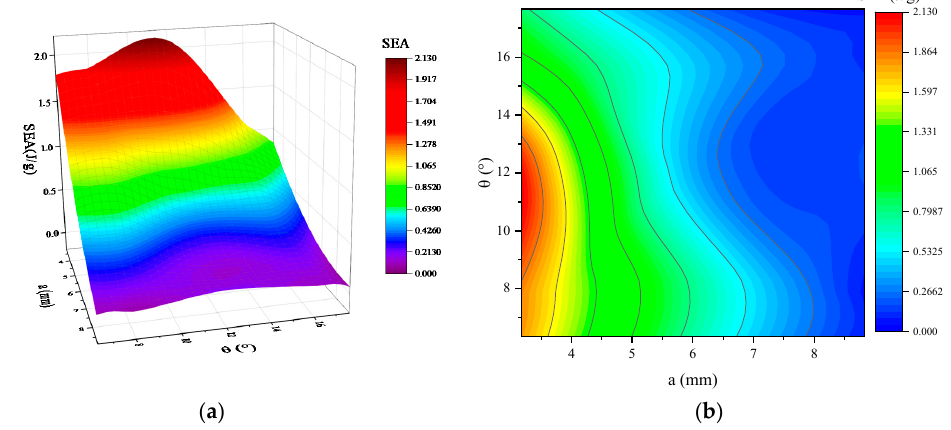
Figure 15. Specific energy absorption ( SEA ): ( a ) 3D surface; ( b ) 2D contour plot.